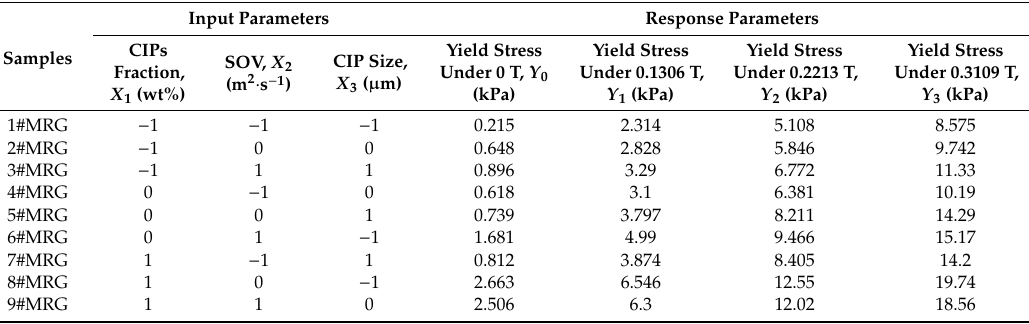
Table 2. Experimental